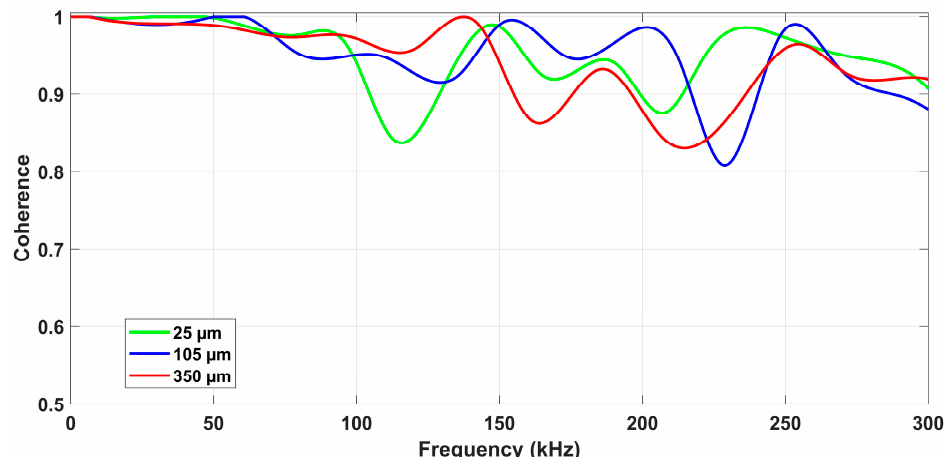
Figure 6. Magnitude-squared coherence between the AE sensor and PZT diaphragm at three grinding conditions.